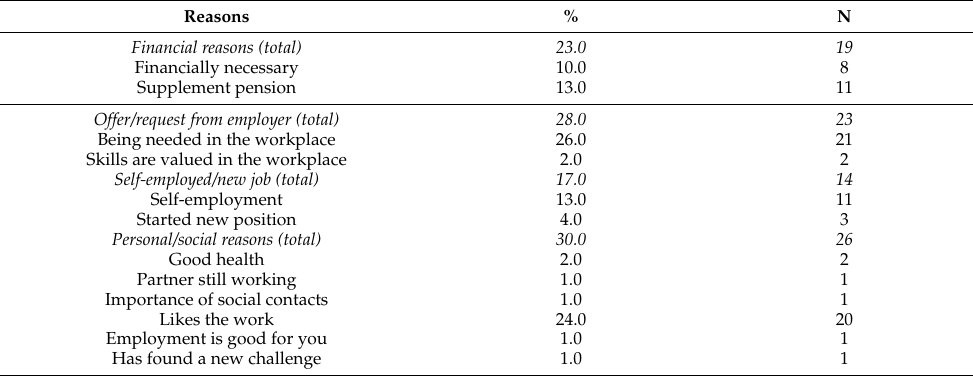
Table 3. Reasons for working beyond the SRA.